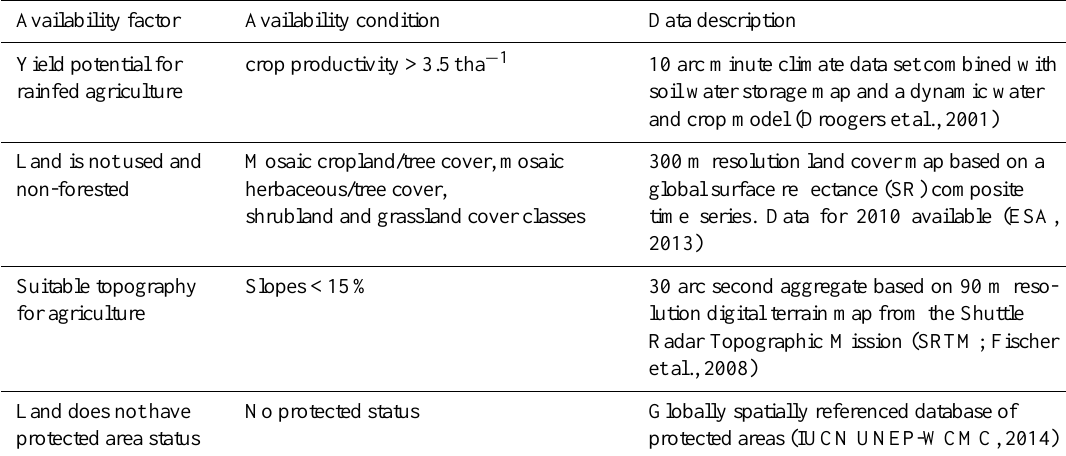
Table 3. Land available for agriculture - data sources and availability